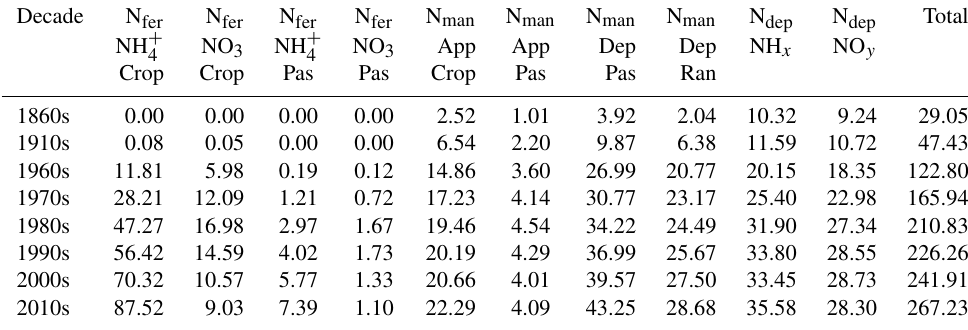
Table 2. Decadal average N inputs to the terrestrial ecosystem (TgNyr − 1 ). Decade N fer N fer N fer